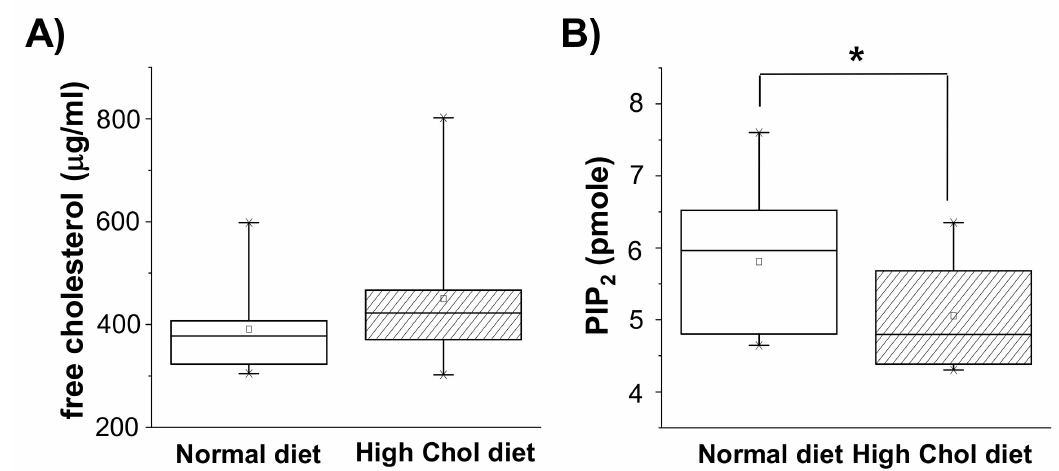
Figure 1. High-cholesterol diet decreased phosphatidylinositol 4,5-bisphosphate (PIP 2) levels in the rat cerebral cortex. Starting at 13 weeks of age, 10 male rats were placed on a high-cholesterol diet and 10 male rats were placed on a normal diet for 6 weeks as described in Materials and Methods. Cerebral cortex was removed and membrane and cytosol fractions were obtained. ( A ) The levels of free cholesterol in the membrane fractions were measured by cholesterol assay kit. Box plots show average cholesterol level in normal diet (open bar) or high-cholesterol diet (hatched bar) groups. The horizontal black lines represent the median of each distribution and the squares indicate means ( n = 10). ( B ) PIP 2 levels in the membrane fractions were measured by using PIP 2 ELISA kit. The levels of PIP 2 were decreased by a high-cholesterol diet ( n = 10). * p <